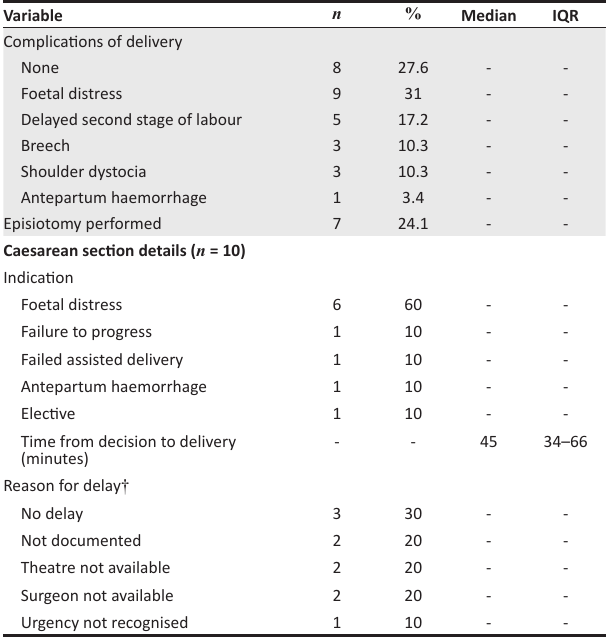
TABLE 2 (Continues...): Course of clinical care at midwife obstetric units and Mitchells Plain District Hospital from admission.